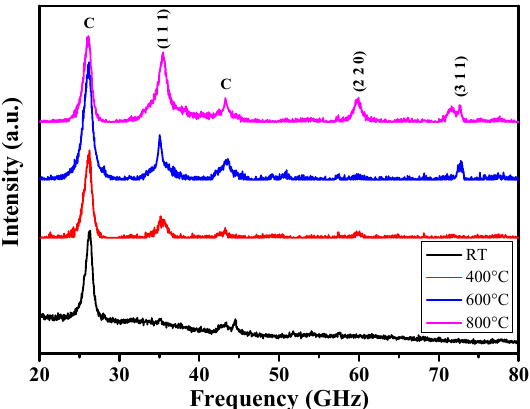
Figure 3. XRD pattern of PCS-coated CNTs pyrolyzed at different temperatures. SEM images of PCS-coated CNTs after heat treatment at different temperatures are shown in Figure 4. When the pyrolysis temperature rises to 400 ◦ C, CNTs of sample P-400 are tightly intertwined with each other and the surface is smooth (Figure 4a). For sample P-600, the SiC grains are fine and have good continuity between each other when coated with CNTs (Figure 4b). However, numerous isolated SiC grains are formed and detached when the pyrolysis temperature increases to 800 ◦ C (Figure 4c). Meanwhile, the surface of sample P-800 becomes gradually rougher, and the grains become more independent because of the increasing pyrolysis temperature. As a result, the compactness of SiC coating is weakened, which in turn reduces the ability to prevent oxygen permeation. The formation of PCS-coated CNTs pyrolyzed at 600 ◦ C is further confirmed by the presence of Si and C element peaks in EDS analysis (Figure 4d,e) [29]. Figure 4f indicates the mass loss curves of different pyrolysis temperatures (400 ◦ C, 600 ◦ C, and 800 ◦ C) and pyrolysis times (0–200 h) on the oxidation resistance of PCS-coated CNTs powders. The oxidation mass loss rate of pyrolysis products at different temperatures varies greatly. Especially, the mass losses of sample P-N and P-400 are 75% and 62%, respectively. These results may be explained by the presence of continuous appearance and the amorphous SiC film. It is worth mentioning that the mass loss of sample P-600 is only 1.9%, which is because the size of SiC crystal obtained at 600 ◦ C is relatively small and prevents the internal oxidation of particles. Therefore, the mass of the sample decreased quite slowly. However, for samples P-800, the mass of SiC-coated CNTs powders decreased to 59% because of the higher SiC content and the larger grain size, resulting in the fact that the SiO 2 film could not be formed after pyrolysis. From the above analysis, it can be concluded that PCS-coated CNTs powders, pyrolyzed at 600 ◦ C, possess the best antioxidant capacity, and the existence of SiC coating effectively prevents the corrosion of CNTs by oxygen and increases the life of CNTs in an aerobic environment.